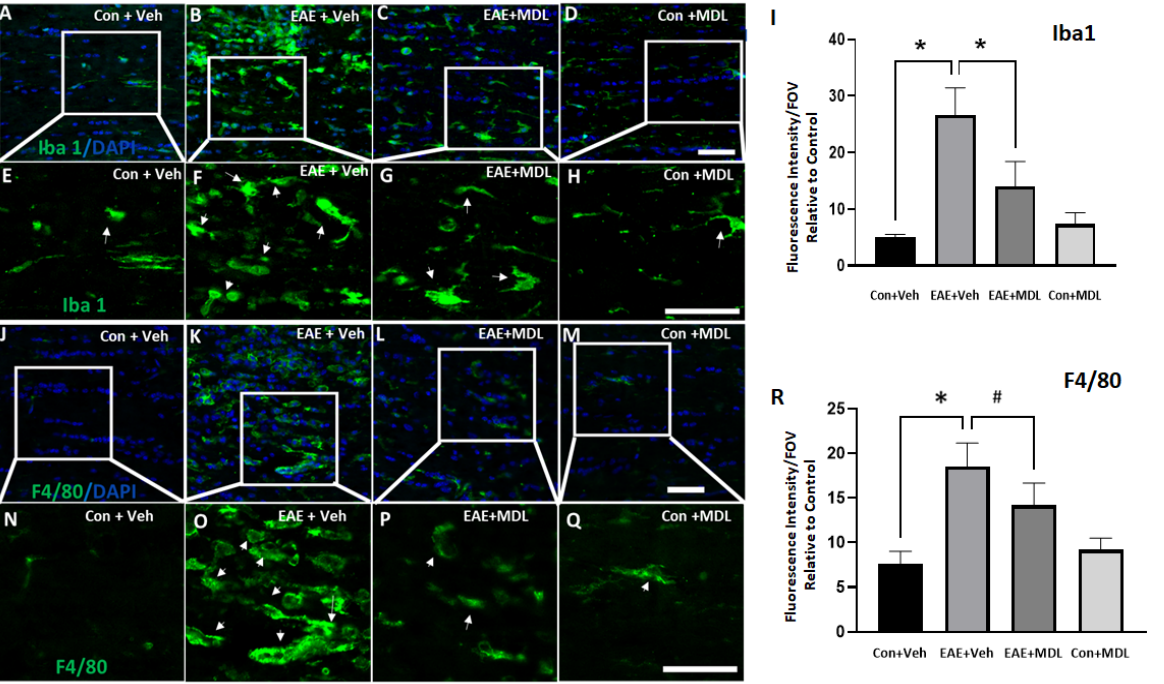
Figure 7. SMOX inhibition reduced the EAE-induced microglia/macrophage activation in the optic nerve. ( A – D ) Confocal images of Iba1 and immunofluorescence staining of optic nerve sections show increases in cells with activated morphology in response to EAE induction and the impact of SMOX inhibition by treatment with MDL 72527. ( E – H ) Magnified images of the boxed regions demonstrate changes in the morphology of Iba1 positive cells and the effects of SMOX blockade. ( I ) Quantification of fluorescence intensity of Iba1 positive cells. ( J – M ) Immunofluorescence staining of optic nerve sections showing the increased population of F4/80 positive cells with activated morphology in response to EAE induction, while SMOX inhibition by treatment with MDL 72527 reduced the effect. ( N – Q ) Magnified images of the boxed regions indicating EAE-induced changes in F4/80 positive cells and the effects of SMOX blockade. ( R ) Histogram showing the quantification of F4/80 fluorescence intensity. Arrows indicate Iba1 or F4/80 positive cells with activated morphology following EAE induction. Data are presented as Mean ± SD. * p < 0.01 and # p < 0.05. Scale bar 50 μ m. n = 5–7 per group and representative images are presented.